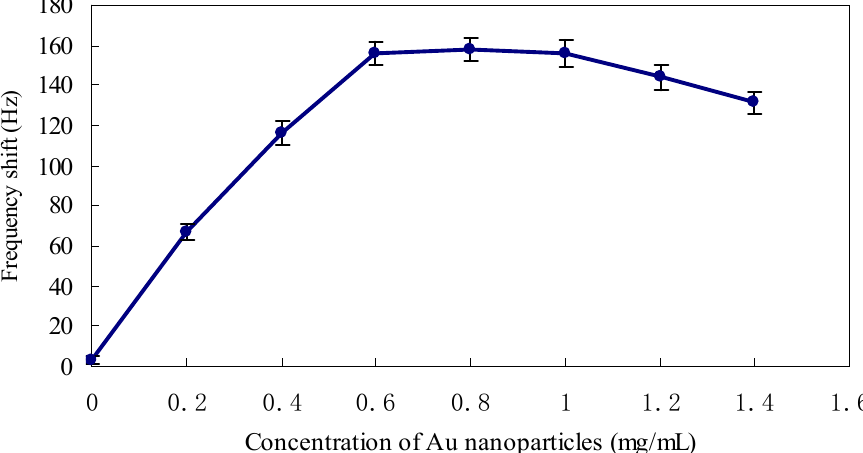
Figure 4. Effect of the Au nanoparticle concentrations on the frequency shifts during signal amplification procedure, frequency shift under the conditions: 2×10 -9 M positive control and pH 7.5 at 37 °C. Error bars indicate the standard deviation